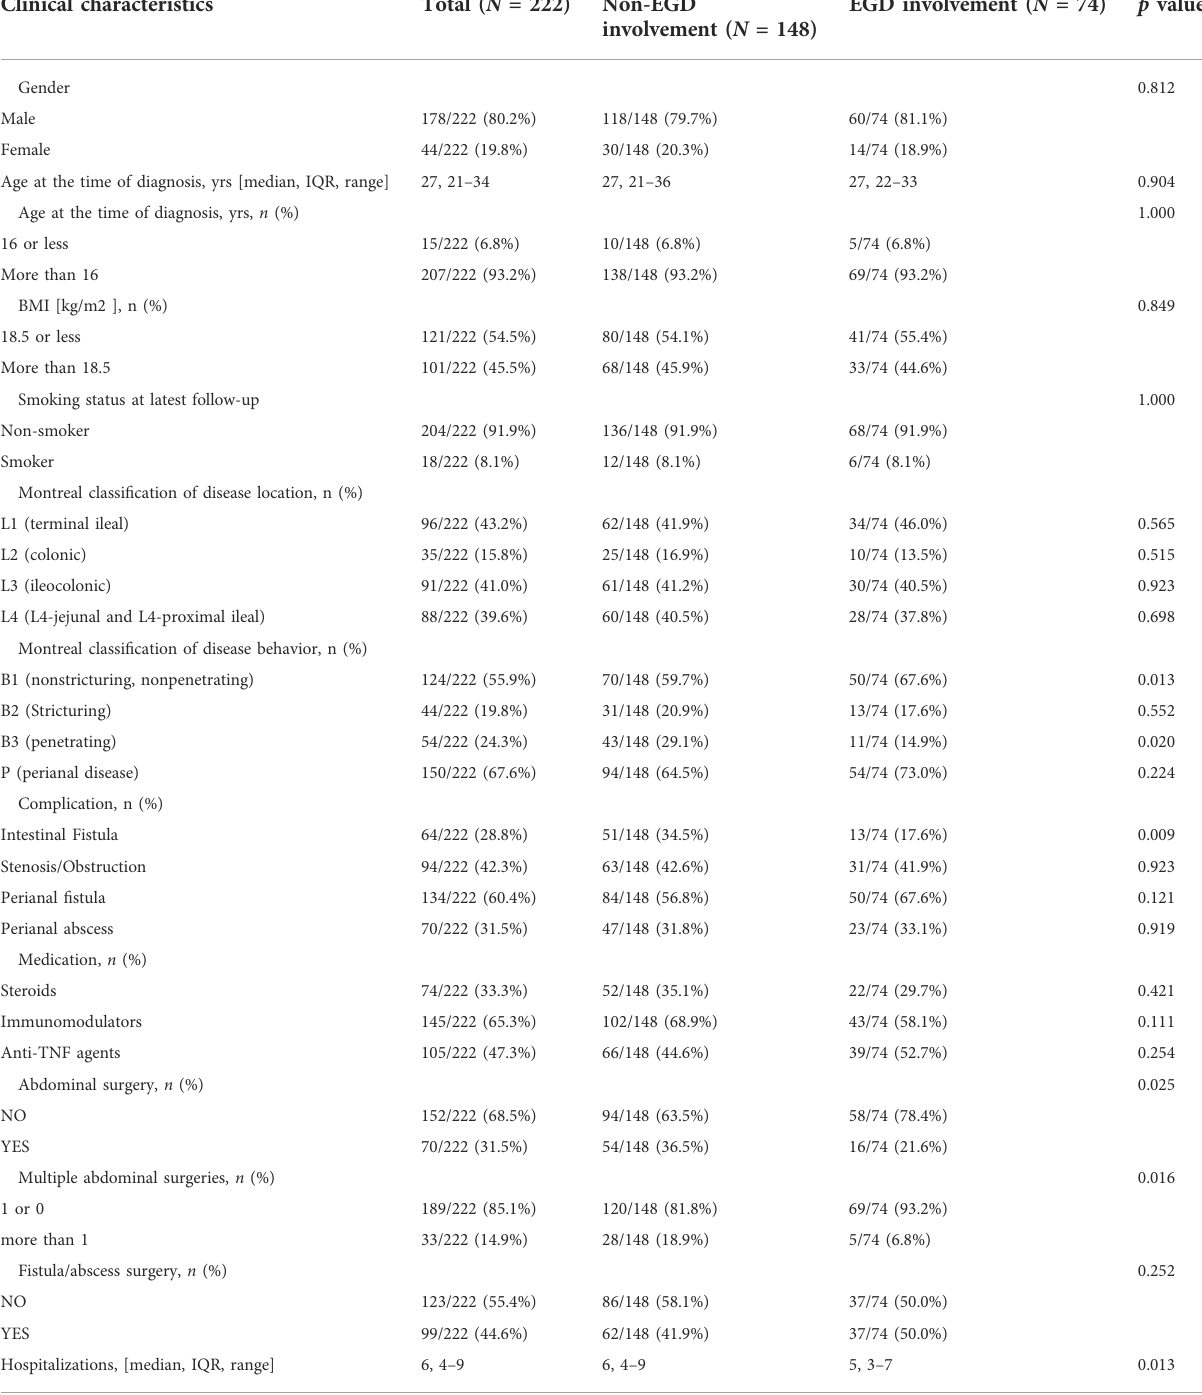
TABLE1Patientdemographicanddiseasecharacteristics ofCDpatientswithEGDinvolvement versus